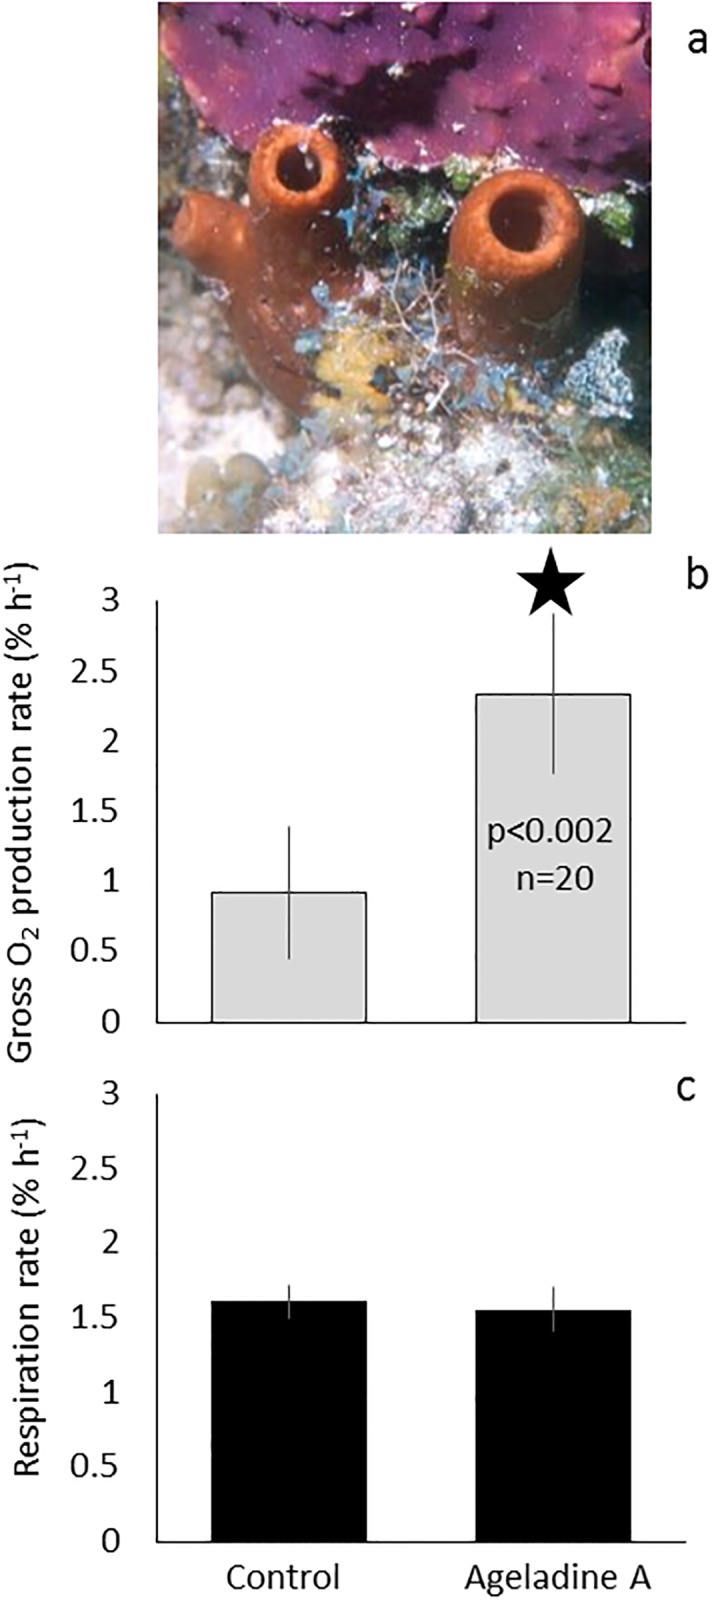
Evidence for a possible type of symbiotic interaction in Agelas sp. sponges (a courtesy [6]). The addition of 30 μmolL-1 Ageladine A resulted in a significant (p<0.002, n = 20) increase of gross O2 production rates in cultures of Synechococcus bacillaris (b). In addition, the respiration rates of these cultures were the same, irrespective of exposure to Ageladine A (c). Experiments for the controls and Ageladine A treatments were conducted in parallel and lasted 600 and 90 minutes for the O2 respiration and production rate measurements, respectively. Values represent mean ± standard error. The star denotes a significant difference between the treatment and the control.